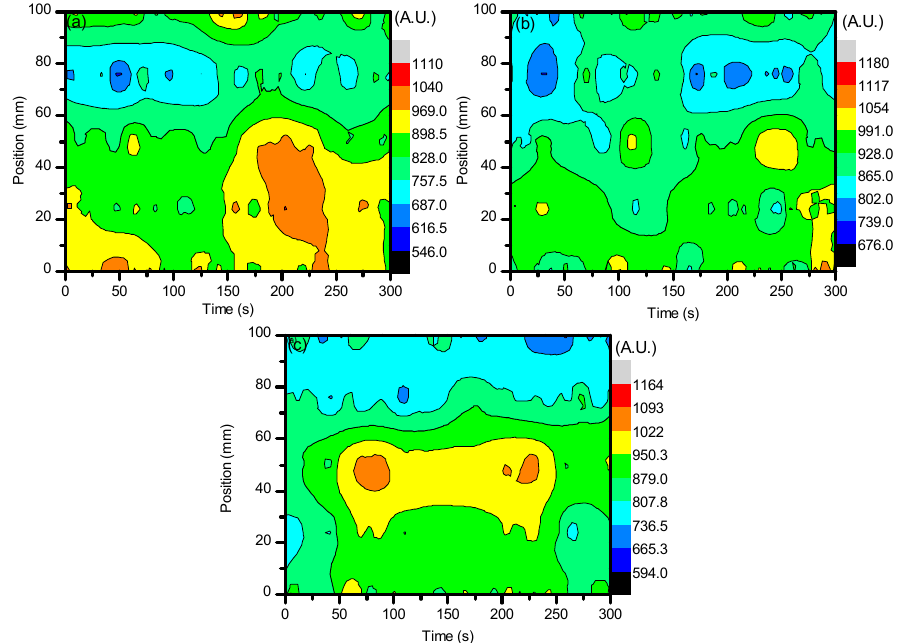
Figure 6. The evolution of O I with respect to the spatial and temporal profile of the ambient air plasma discharge is shown here with an applied voltage of 27 kV, 29.6 kV, and 32 kV, shown in ( a – c )